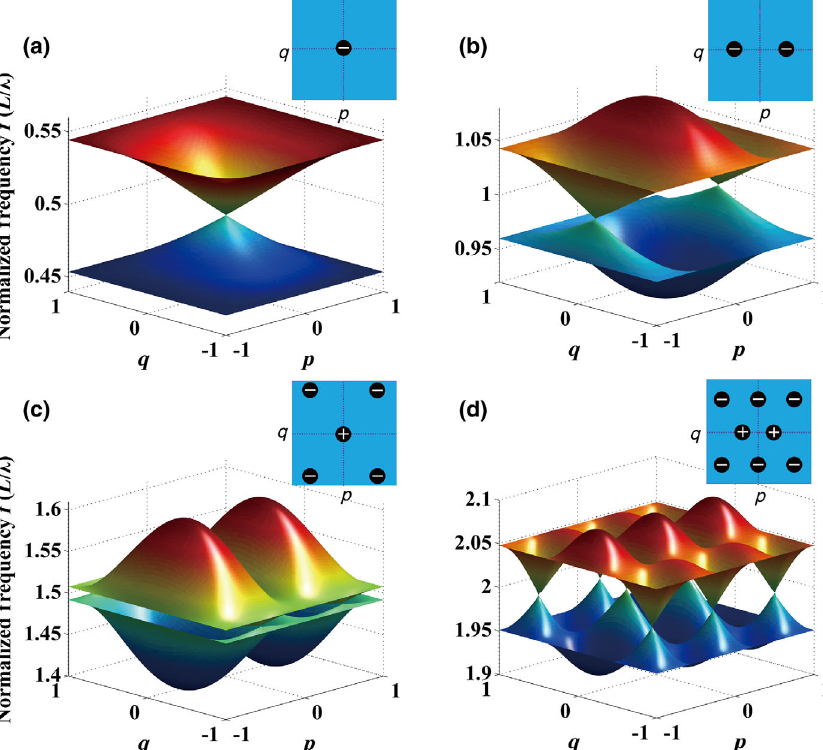
FIG. 2. The band dispersions in the parameter space at different k points. (a) Bands 1 and 2 at k ¼ 0 . 5 k 0 . (b) Bands 2 and 3 at k ¼ 0 . (c) Bands 3 and 4 at k ¼ 0 . 5 k 0 . (d) Bands 4 and 5 at k ¼ 0 . The conical intersections in (a) – (d) all correspond to Weyl points with positions and charges ( “ þ ” for charge þ 1 , “ − ” for charge − 1 ) marked in the insets, in which the dashed lines denote p ¼ 0 or q ¼ 0 . Here, we use the same parameters as those in Fig.